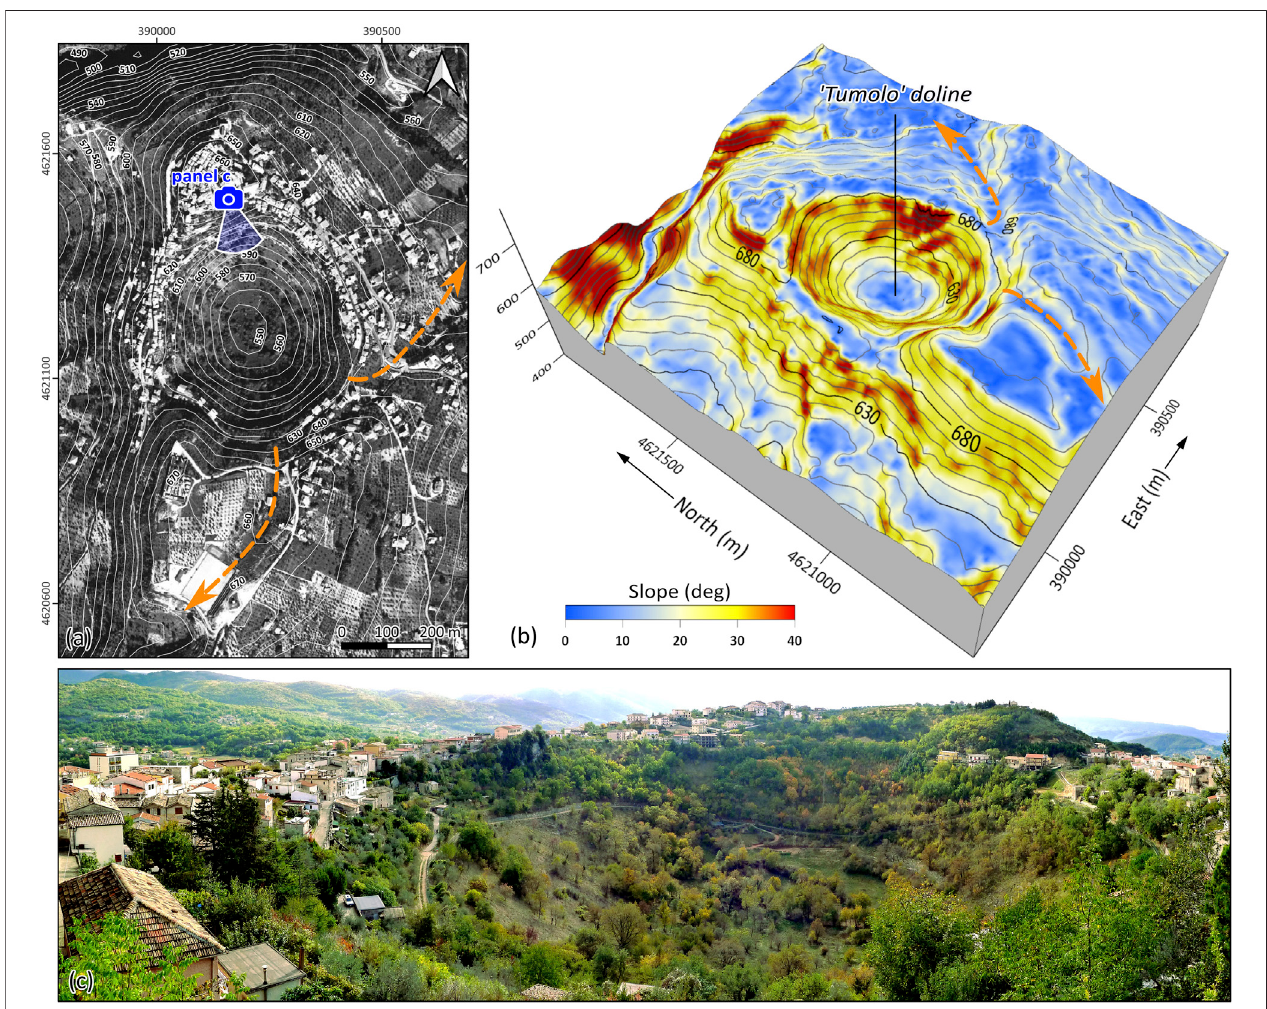
FIGURE7| Tumolo doline(the dashedyellowrectanglein Figure4A ). (A) Blackandwhiteorthophotowiththeindication ofdryvalleys(thedashed orangearrows) (B) Three-dimensional sketch with the slope angle. (C) Panoramic view (the picture location and orientation are in panel a).